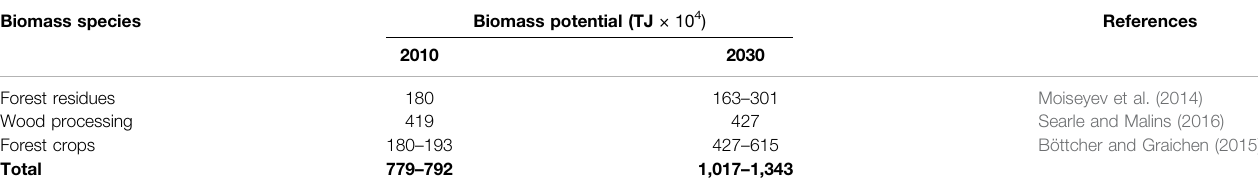
TABLE 1 | Statistics by the EU on energy generation from different types of forest biomass in 2010 and estimated values in 2030. Biomass